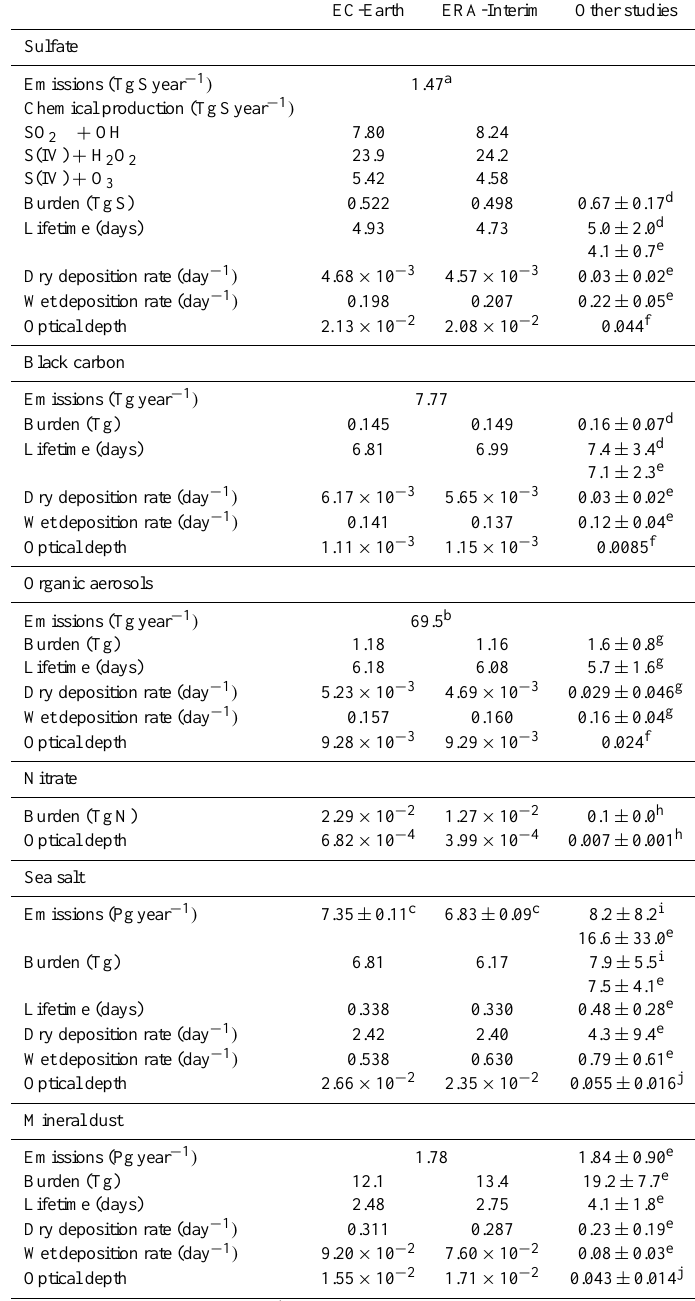
Table 6. Global budgets, burdens, and lifetimes of the different aerosol components for the reference EC-Earth simulation and the corre- sponding ERA-Interim simulation. Estimates of their contributions to the optical depth at 550nm are also included. The results are compared with estimates from other